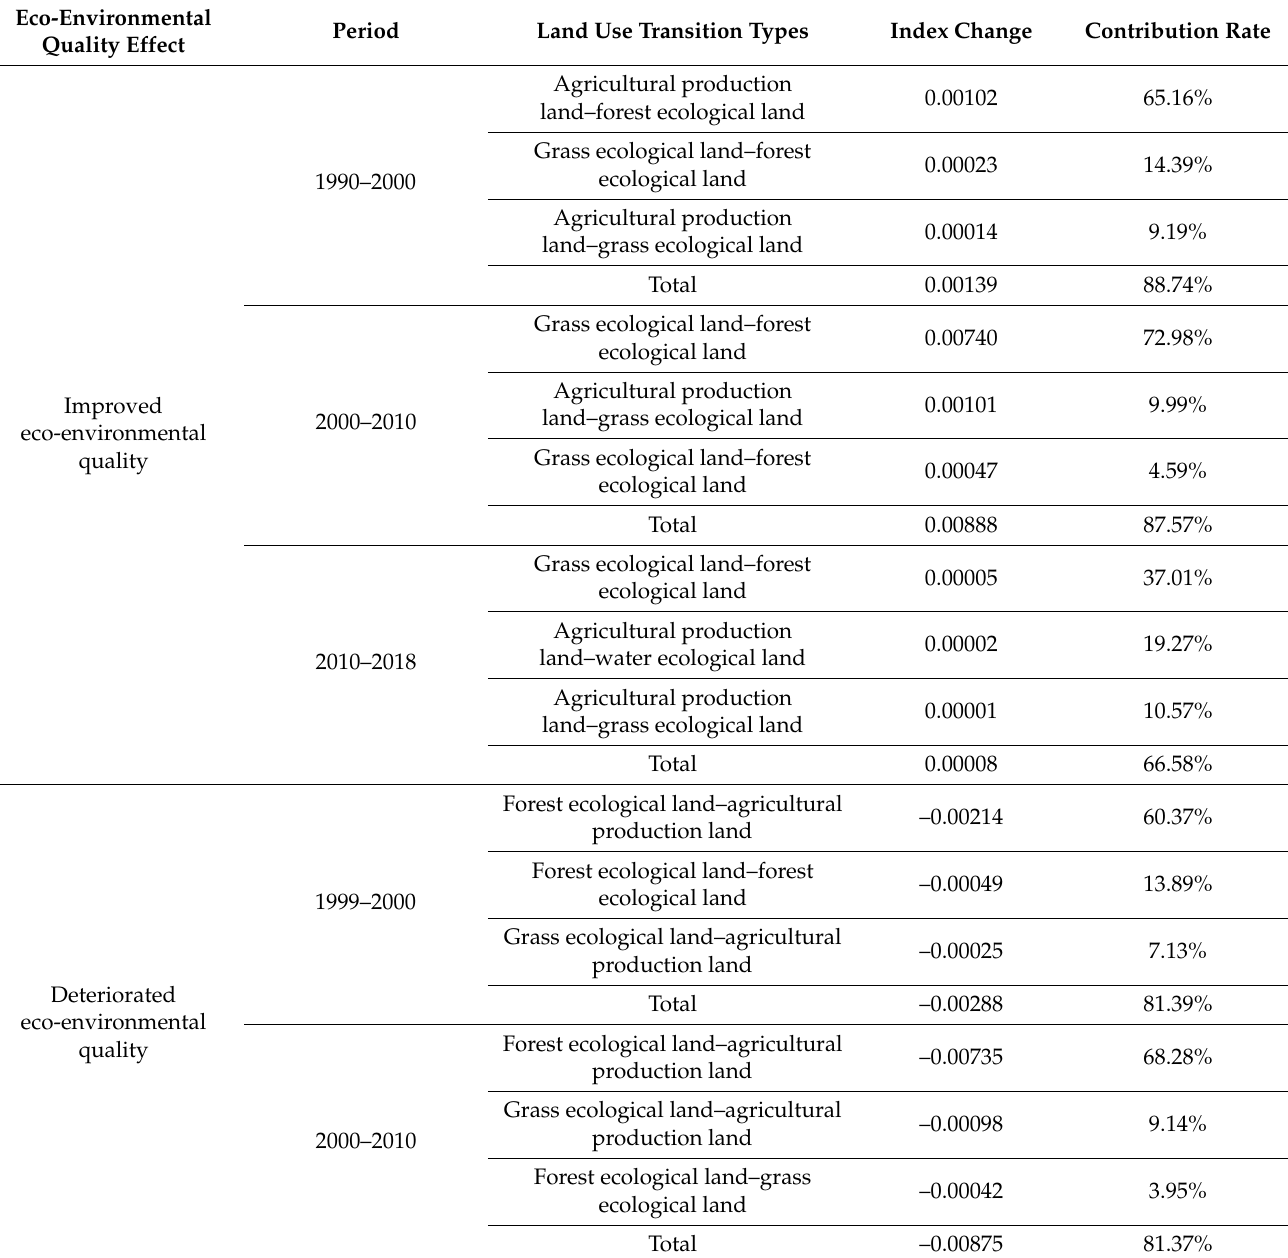
Table 6. Contribution of land use transition affecting eco-environmental